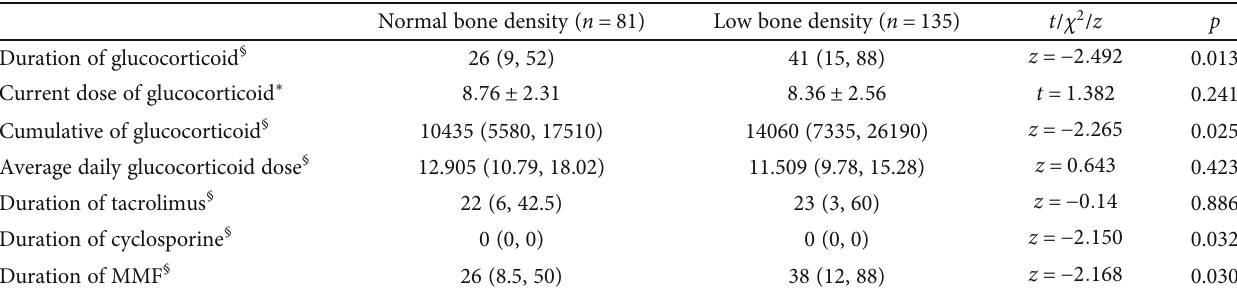
Table 3: The use of immunosuppressive drugs in the patients. Normal bone density ( n = 81 )